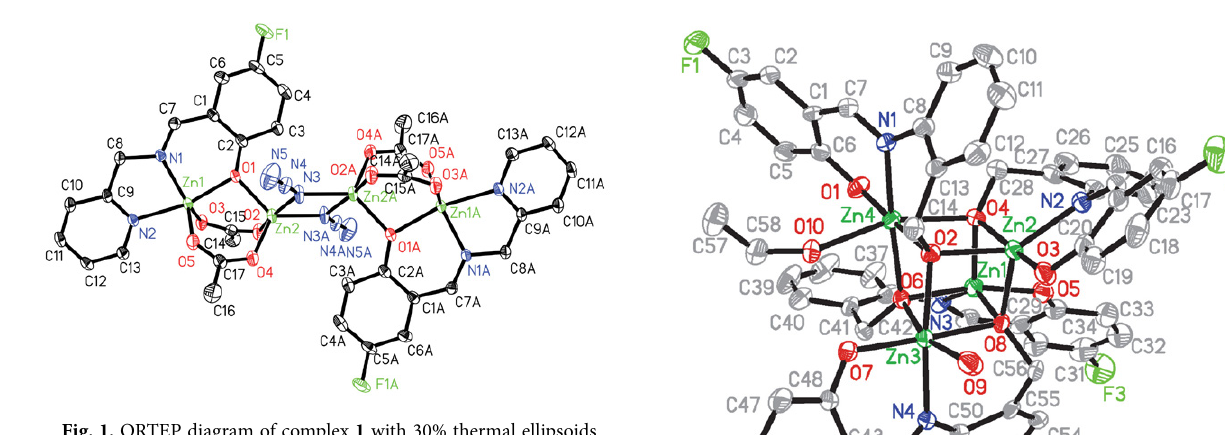
Fig. 1. ORTEP diagram of complex 1 with 30% thermal ellipsoids for all non-hydrogen atoms. Hydrogen atoms are omitted for clarity. Atoms with the suffix A are related to the operate position – x , 1 – y , 1 – z .